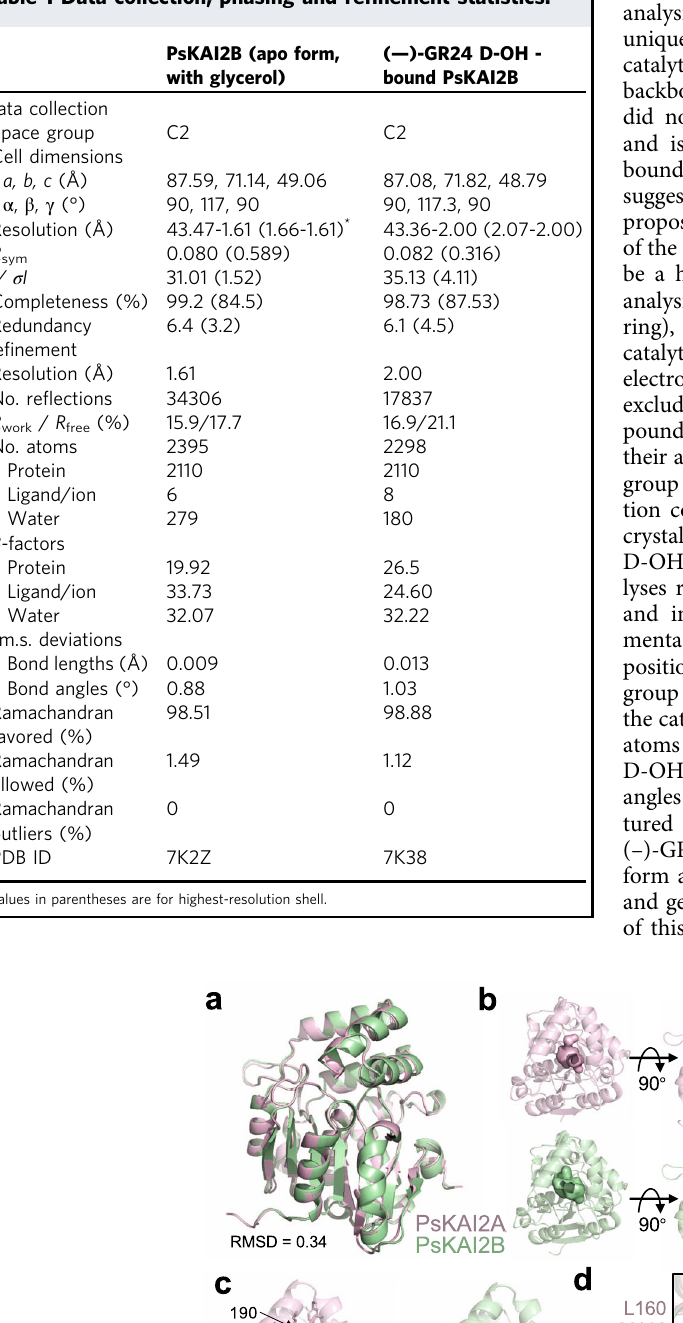
Table 1 Data collection, phasing and re fi nement statistics.